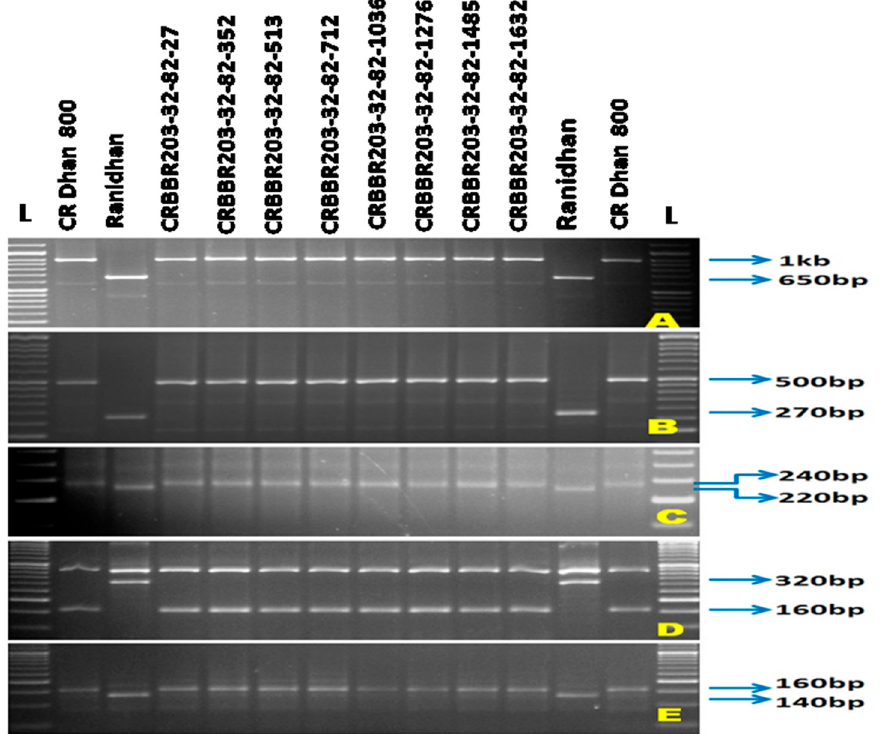
Figure 5. Electropherogram of BC 3 F 2 derivatives of rice variety Ranidhan for four BB resistance genes, Xa21, xa13 , xa5 and Xa4, using markers ( A ) pTA248 for Xa21 ; ( B ) Xa-13 prom for xa13 ; ( C ) RM122 & ( D ) xa5S/R (Multiplex) for xa5 ; ( E ) MP-Nbp-131 for Xa4 . Lane 1, 14: 50 bp ladder; Lane 2, 13: CR Dhan 800; Lane 3, 12: Ranidhan; Lane 4–11: BC 3 F 2 derivatives of rice variety, Ranidhan.